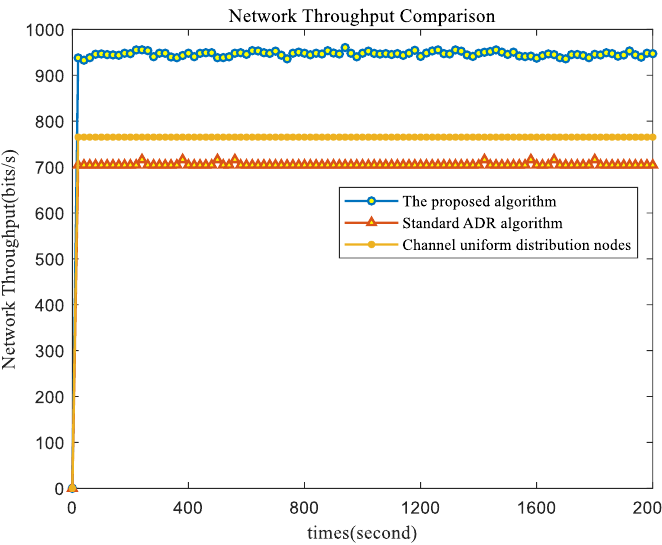
Figure 17. Number of the different channel EDs after the rate adjustment by the proposed algorithm.